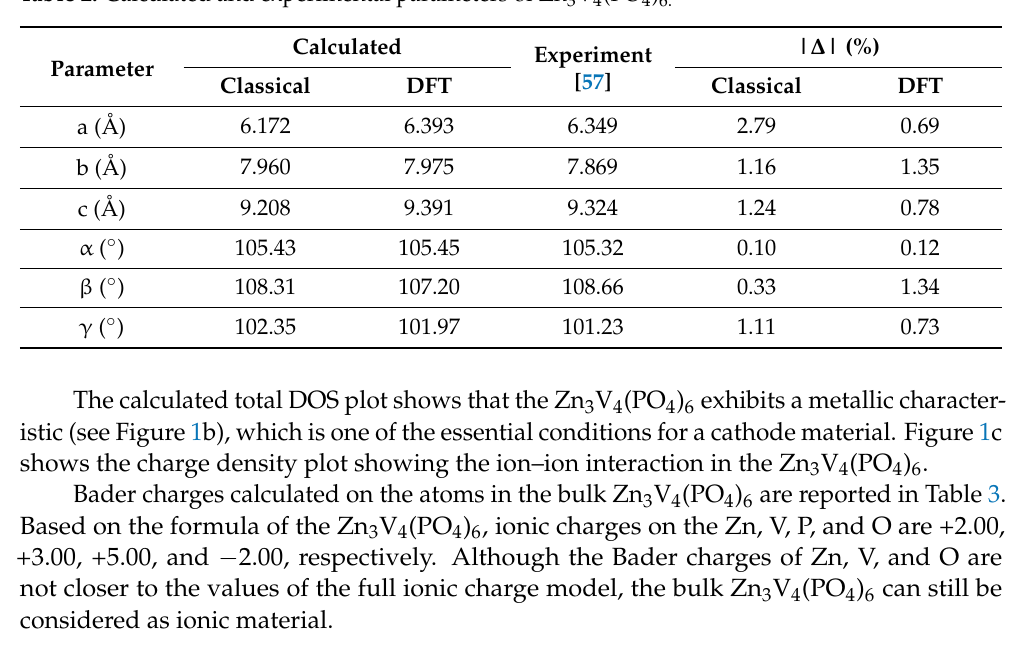
Table 3. Calculated Bader charges on the atoms in bulk Zn 3 V 4 (PO 4 ) 6 .